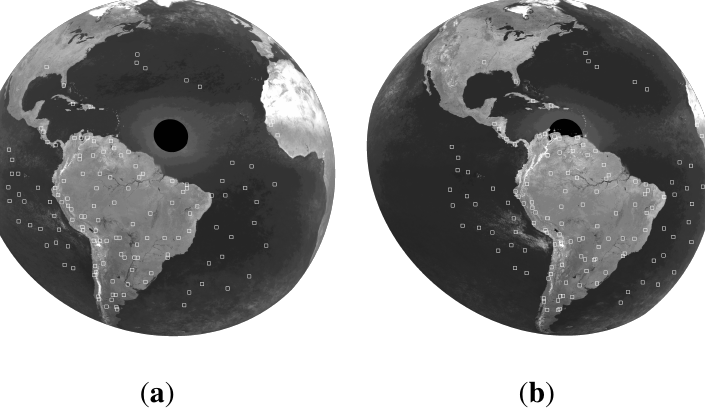
Figure 9. The selected clear-sky stable sites for the 134 overlapping sites for ( a ) the ADC at 50 ◦ W and ( b ) the XADC at 75 ◦